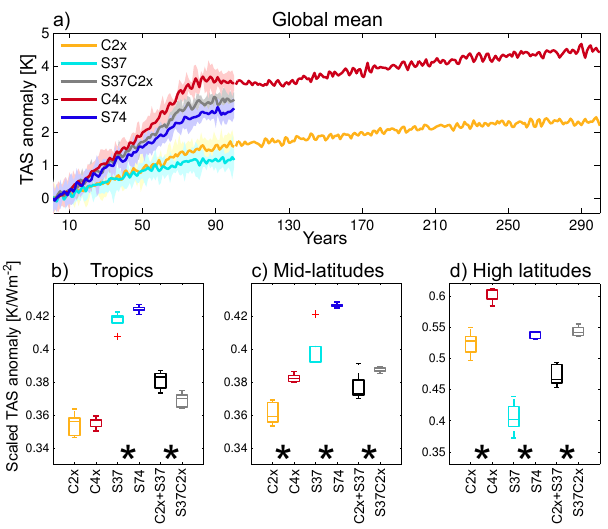
Fig. 1. (a) Time series of the global annual mean anomaly of surface air temperature (TAS) [K] for all five scenarios. Averages over five initial condition ensemble members for the 100yr simulations and over 3 members for the 300yr simulations are shown. Shading extends from the lowest to highest value obtained by any of the five ensemble members. Regional surface air temperature anomalies scaled by the adjusted forcing [KWm − 2 ] in the scenarios are shown for (b) the tropics, (c) the mid-latitudes and (d) the high latitudes (see text for definition of the sub-regions). Asterisks are displayed whenever the pairs of scenarios (C2x and C4x, S37 and S74, S37C2x and C2x+S37) are significantly different from each other (two-sample Kolmogorov–Smirnov test, significance level 0.05) and therefore indicate when the linear additivity assumption is not valid. Red crosses are outliers.